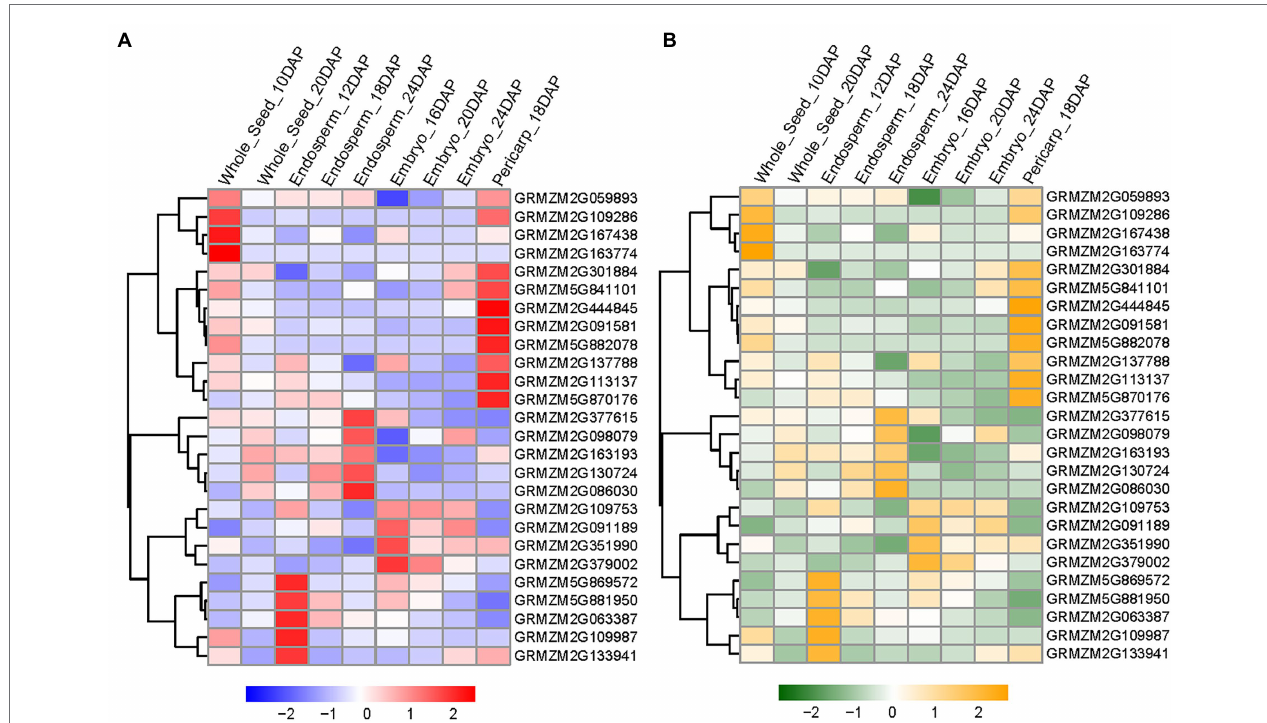
FIGURE 4 | Expression and protein accumulation profiles of candidate genes identified by GWAS. (A) The heat map exhibits expression patterns of candidate genes during seed development. Log2-based fold change is used to create the heat map and fold changes are shown in color. (B) The heat map exhibits protein accumulation of candidate genes during seed development. Log2-based fold change is used to create the heat map and fold changes are shown in